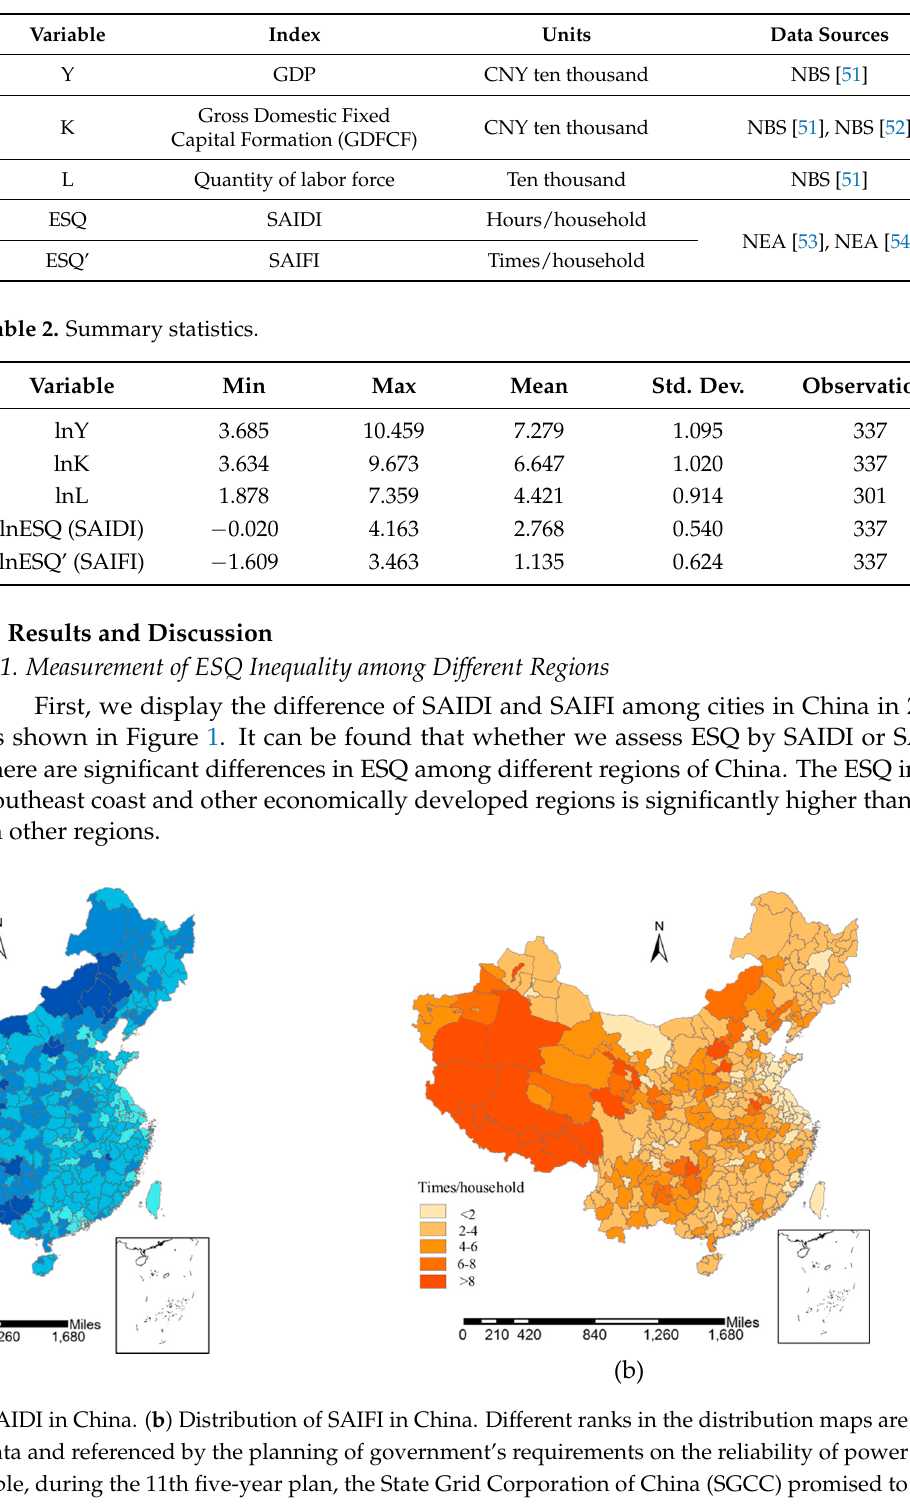
Table 1. Data used in the regression.